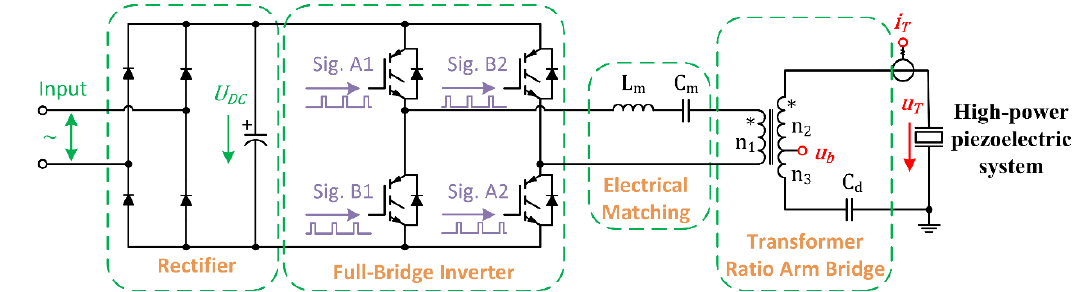
Figure 6. The proposed electrical scheme.